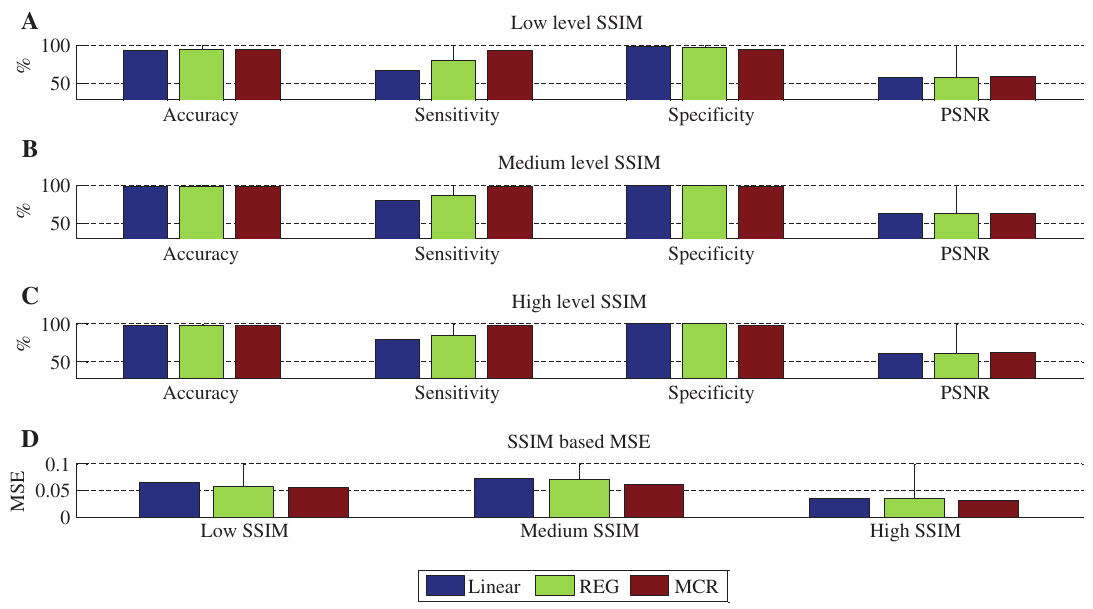
Figure 8: Bar Graph Showing Performance Analysis Based on Three Different Levels of